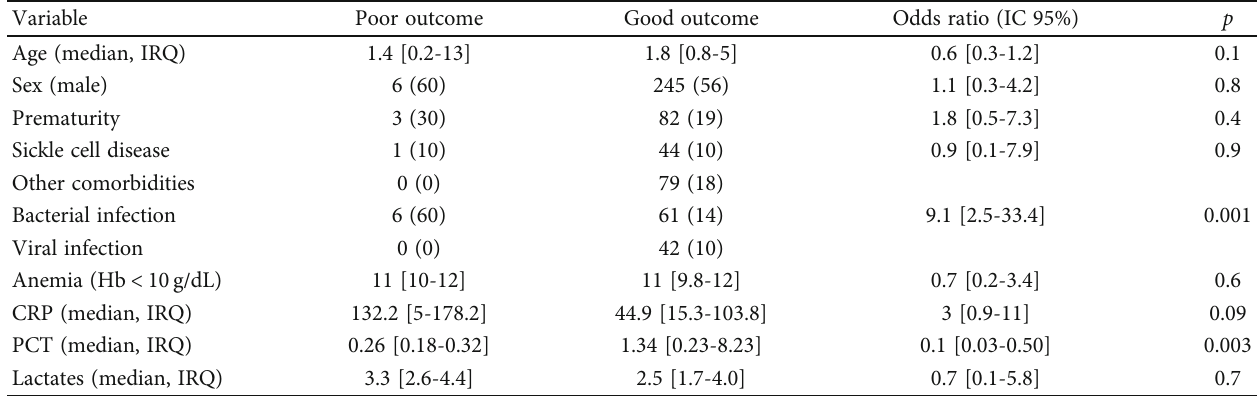
Table 1: Univariate analysis of predictive factors of poor